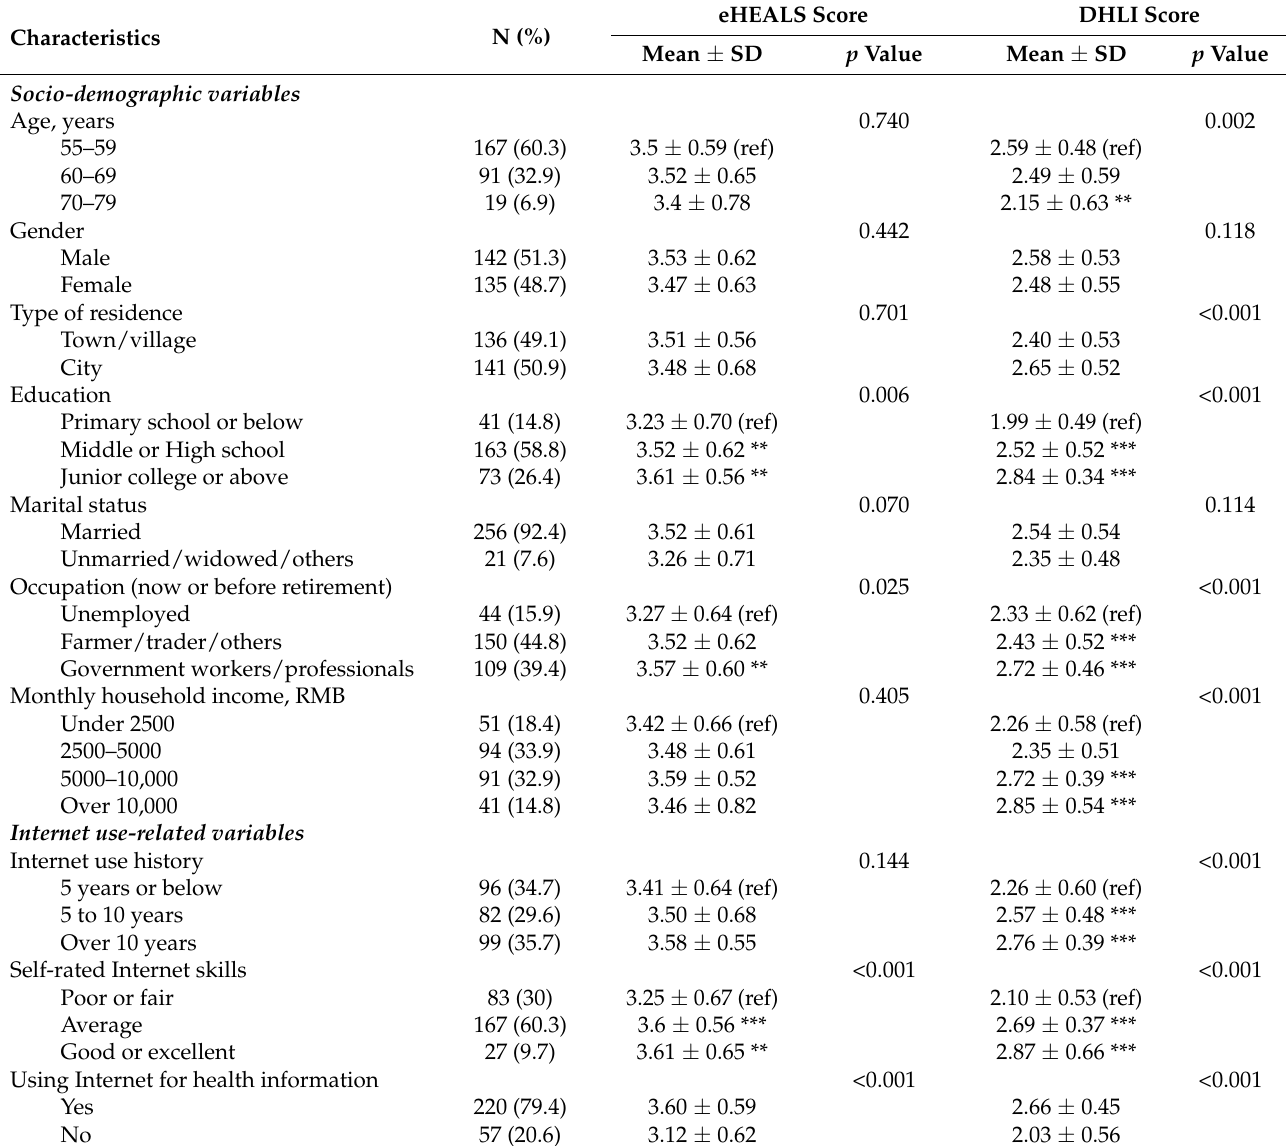
Table 1. Characteristics of the participants (N =